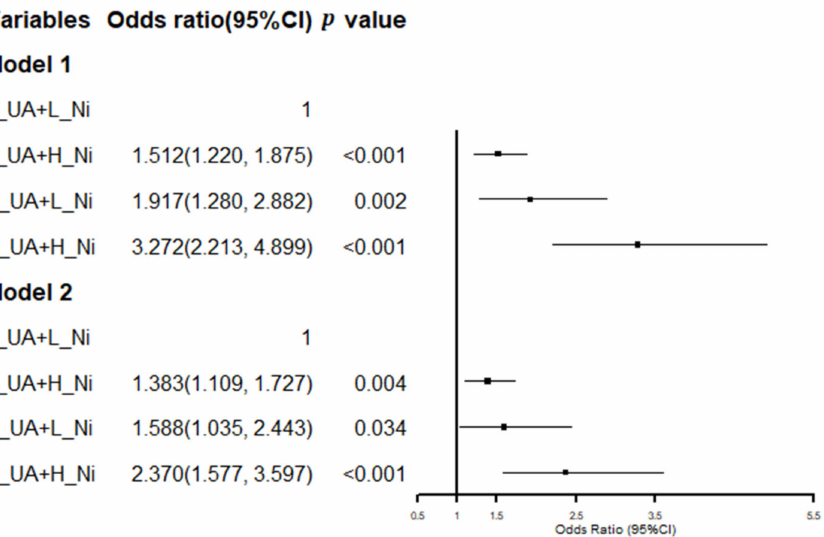
Figure 5. Conjunctional relationship of SUA and serum Ni on NAFLD. H_SUA ≥ 420 µ mol/L; H_ Ni, high nickel, was defined as >2.53 µ g/L; Model 1: adjusted for age and BMI; Model 2: further adjusted for SBP, DBP, ALT, AST, ALP, TBIL, TC, TG, LDL-C, HDL-C, fasting glucose, HbA 1C, meat consumption, and vegetable